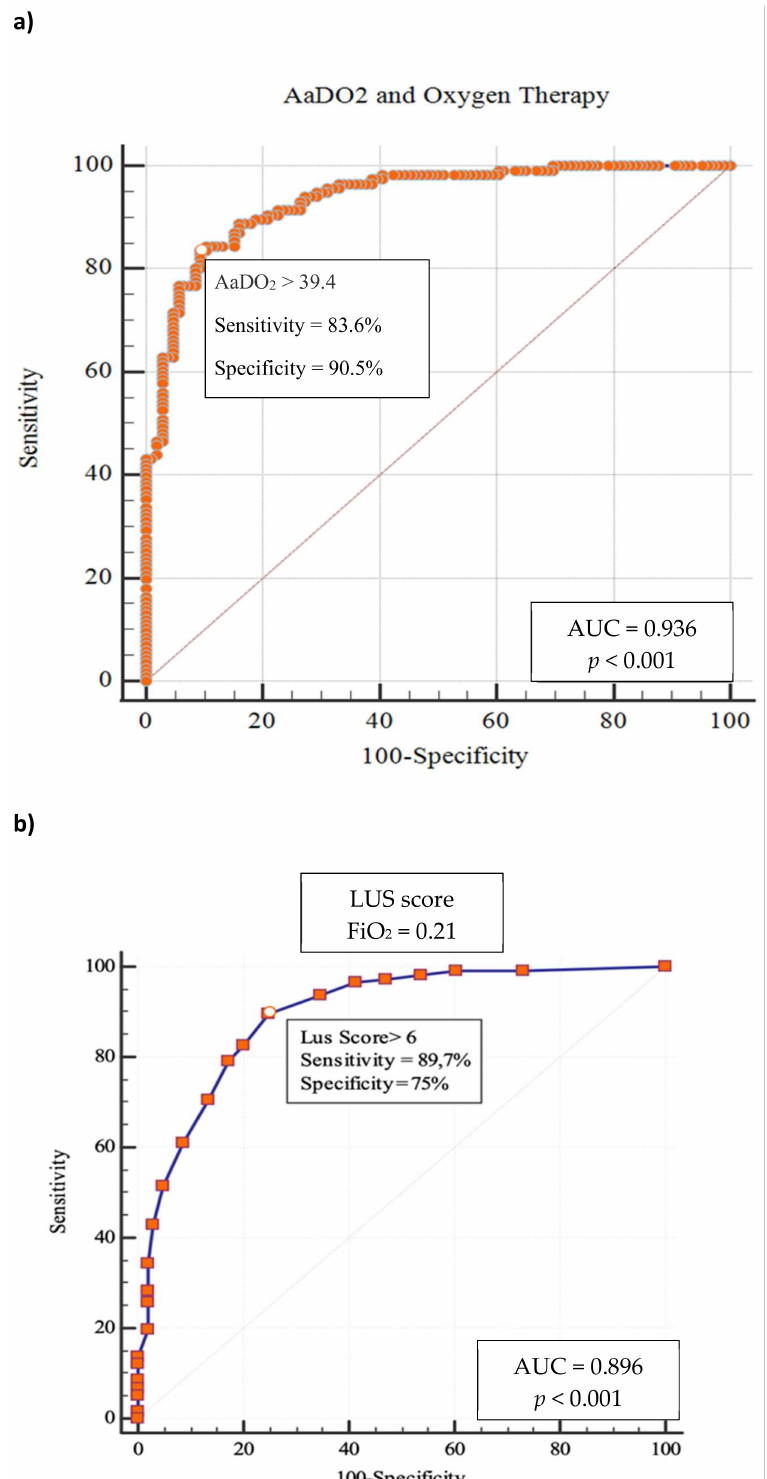
Figure 4. ROC curves in whole cohort. ( a ) AaDO 2 and Oxygen Therapy. ( b ) LUS score and Oxygen